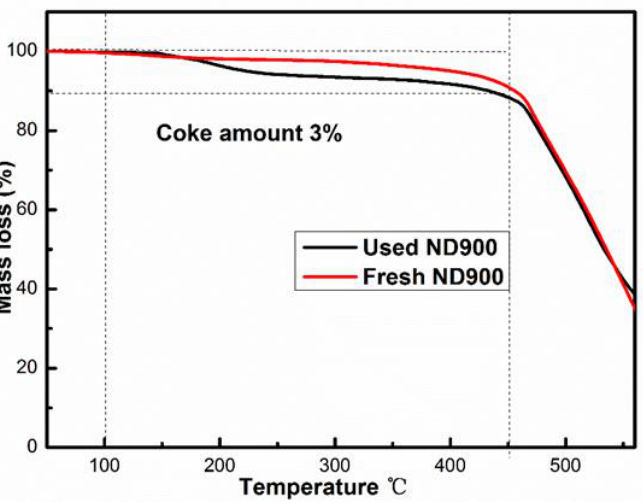
Figure 6. Thermogravimetric analysis (TGA) curves recorded in an air atmosphere of fresh and used ND900 catalyst.